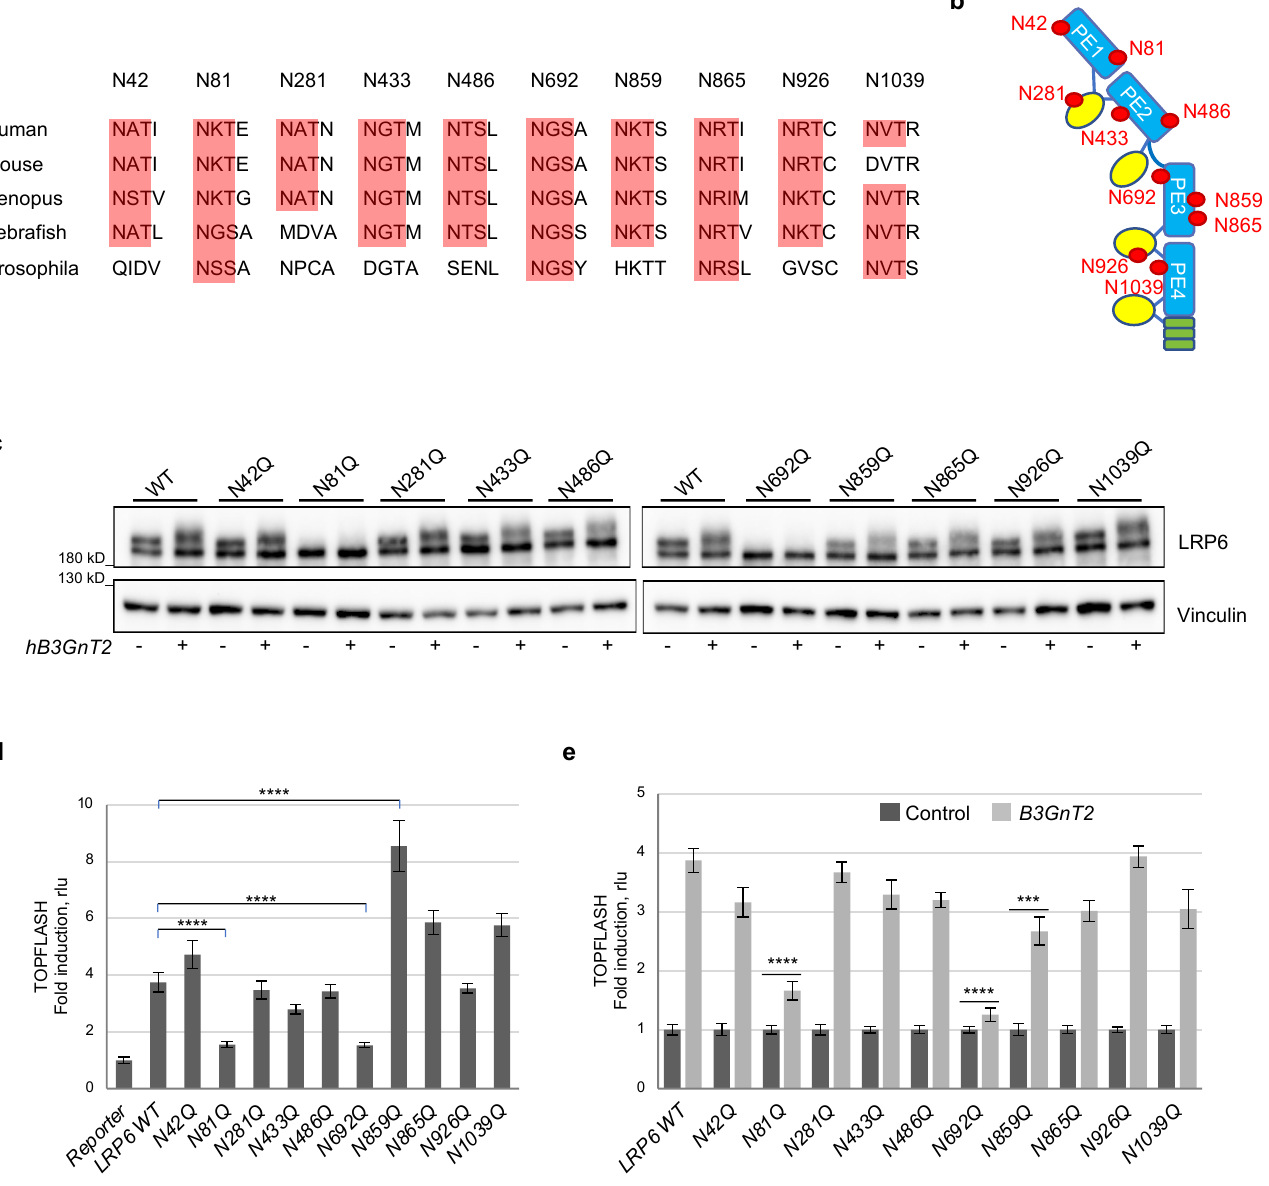
Figure 4. Multiple N-glycan sites of LRP6 are relevant for B3GnT2-mediated LRP6 promotion. ( a ) Evolutionarily conserved N -glycosylation sites. Red: asparagine (N) residues predicted to